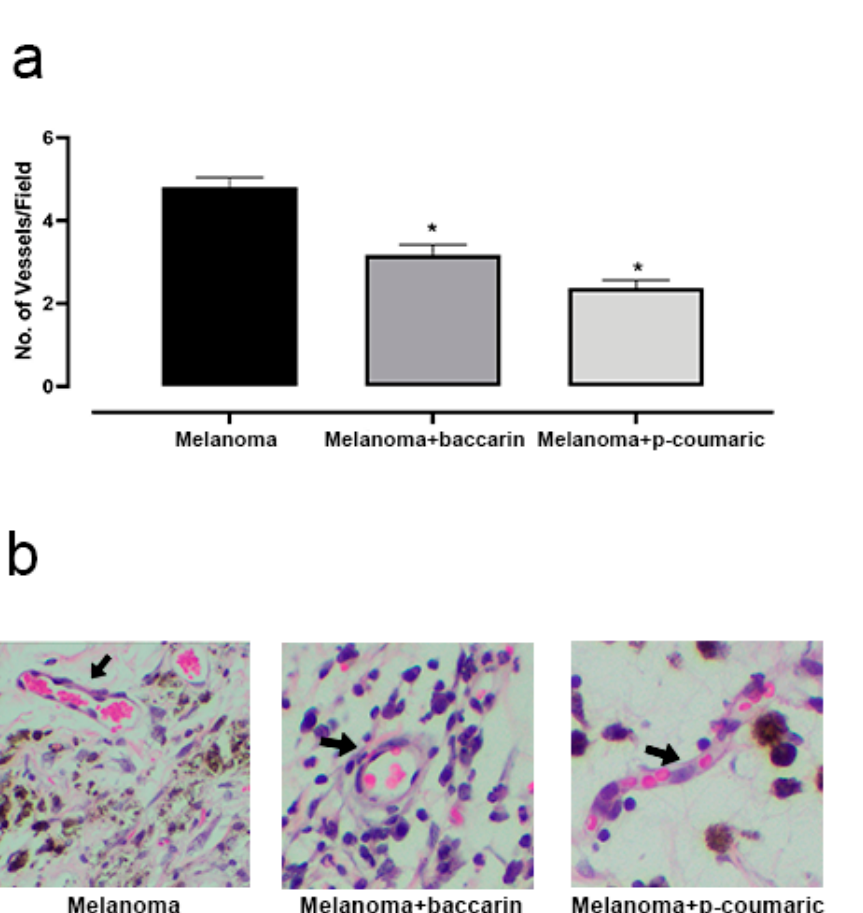
Figure 3. ( a ) Representative graphic of the vessel’s analysis. Baccharin and p-coumaric acid reduces the process of angiogenesis. Comparison between the Melanoma groups (B16F10 concentration of 10 6 cell/mL) that ingested only PBS and the Melanoma + baccharin group that received treatment with baccharin compound (500 µ g/kg) for 26 days. Comparison with the Melanoma group (B16F10 concentration of 10 6 cell/mL) that ingested only PBS and Melanoma + p-coumaric acid group that received treatment with p-coumaric compound (500 µ g/kg), for 26 days. ( b ) Representative images of the histological section of blood vessels in 200 × magnification. Data represents mean ± SEM. * These differences were considered significant with p < 0.05.